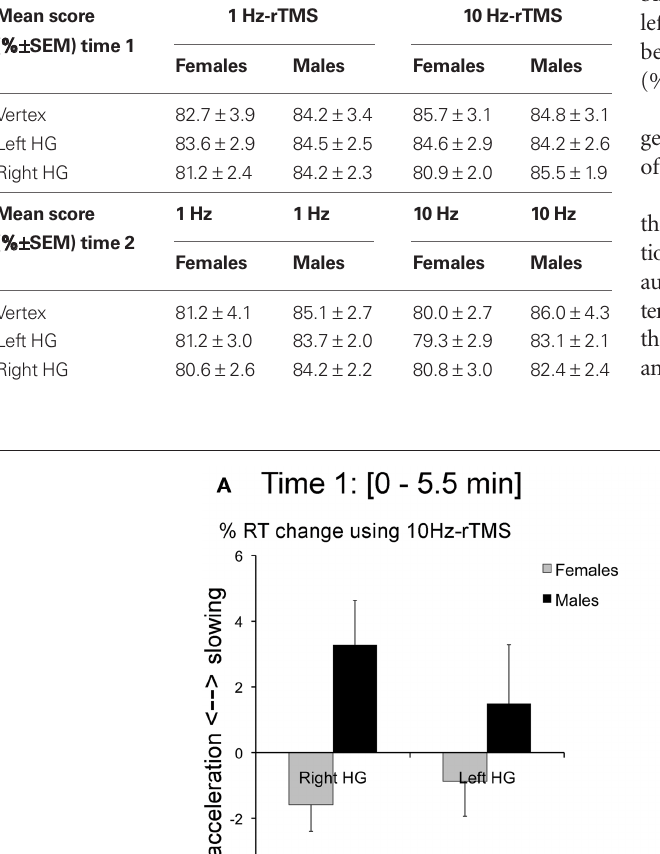
Figure 5 | (A) At time 1 (0–5.5 min after rTMS; left) %RT change with 10 Hz-rTMS targeting the right or left HG calculated relative to rTMS applied over the Vertex for the female group (black bars) and the male group (gray bars). (Right) %RT change with 1 Hz-rTMS targeting the right or left HG calculated relative to rTMS applied over the Vertex for the female group and the male group. (B) At time 2 (5.5–11 min after rTMS; left) %RT change with 10 Hz-rTMS